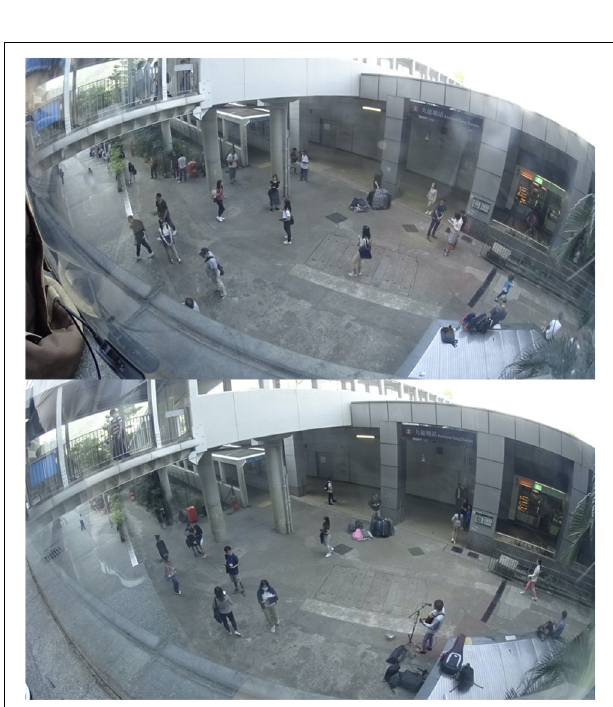
FIGURE 5 | Quasi-experiment location without (top) and with (bottom) street performance.